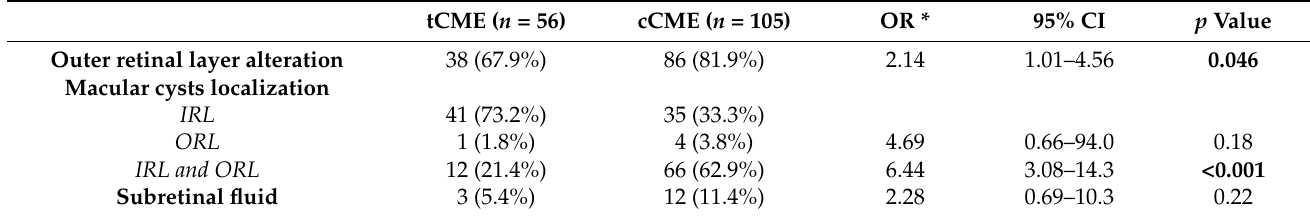
Table 4. Cystoid macular edema characteristics in SD-OCT imaging.